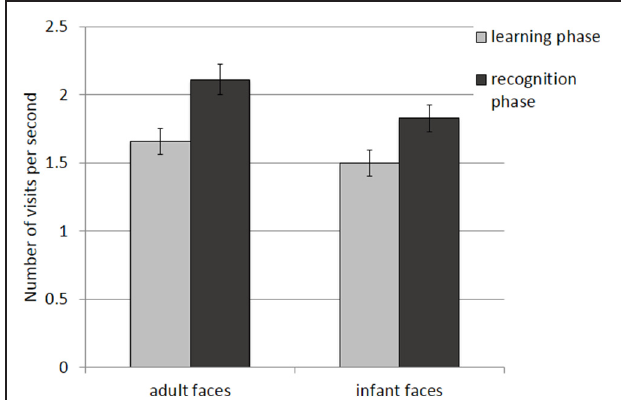
FIGURE 4 | Number of visits per second recorded on all trials during the learning and recognition phase for adult and infant faces. Error bars represent the standard error of the means.